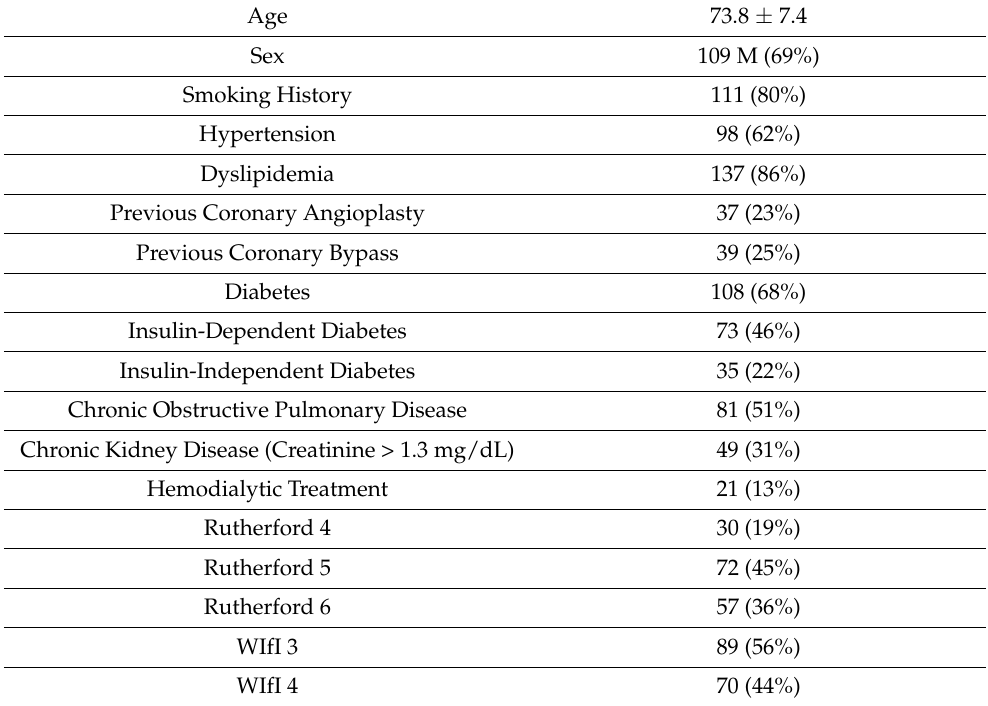
Table 1. Demographic and baseline